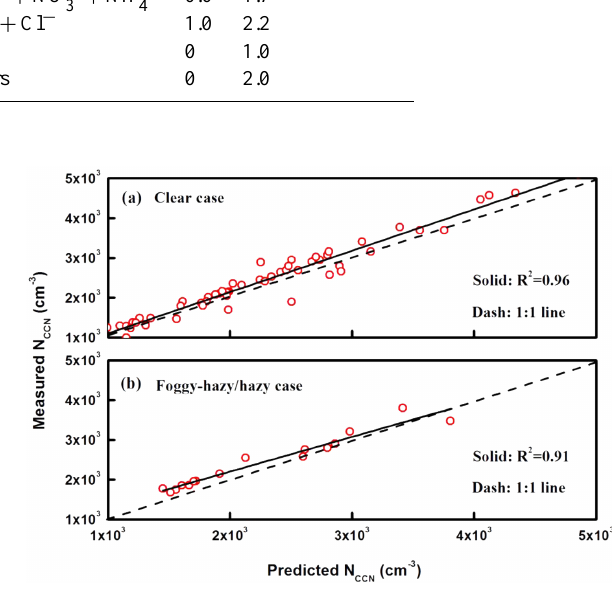
Figure 9. Correlations of BC mass concentration ( M BC ) to N CCN and N CCN /N CN (0.2% SS).